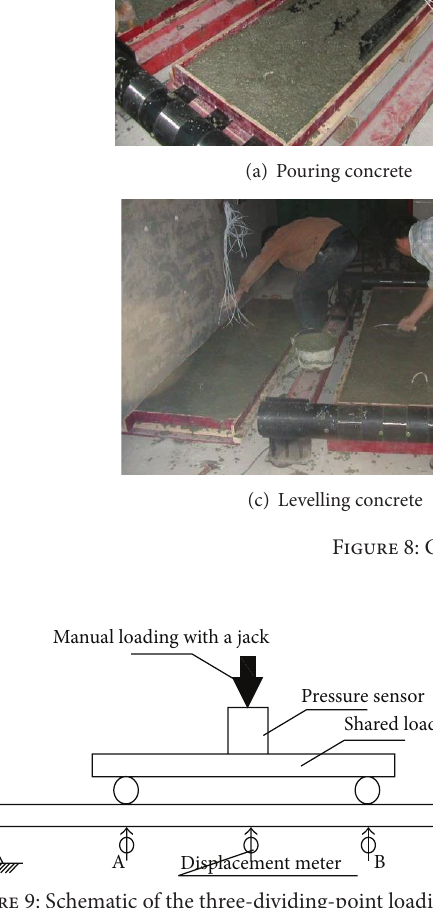
To obtain the mechanical properties of the concrete slab during the loading process, concrete strain gauges are attached to the roof and the bottom of the concrete slab at the